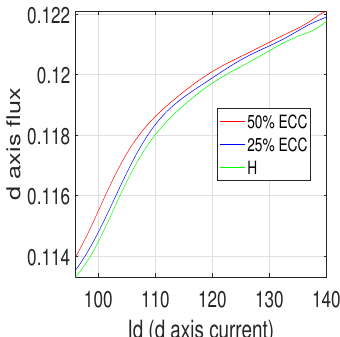
Figure 14. Experimental results for λ d vs. I d at different severities.